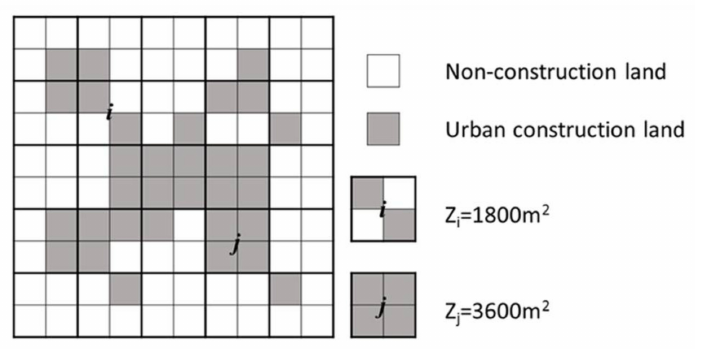
Figure 2. Grids in two-dimensional (2D) urban compactness model